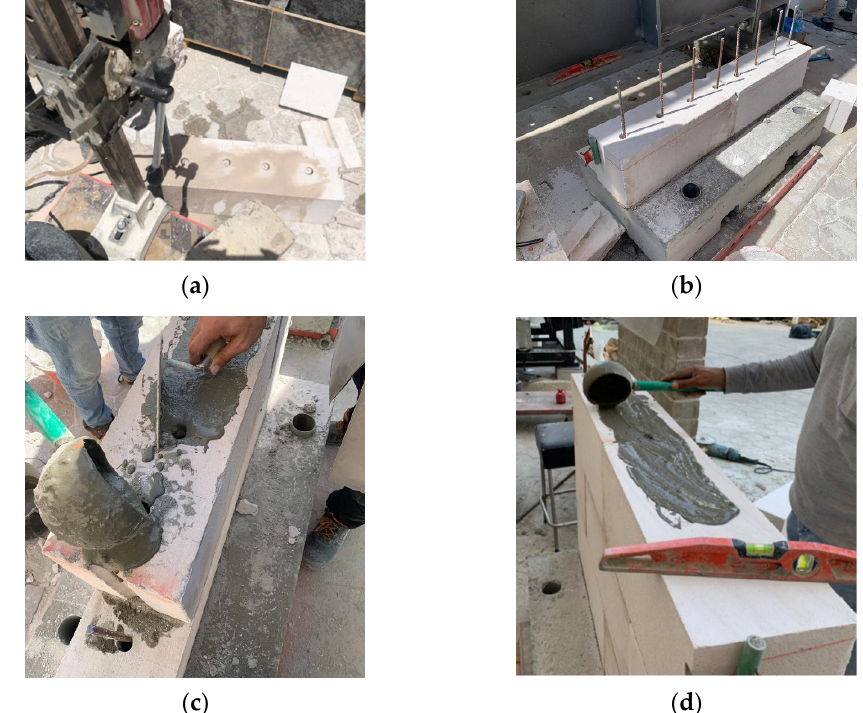
Figure 11. ( a ) Drilling holes in the first two block layers to run dowel bars through, ( b ) placement of the first block layer, ( c ) filling the holes with grout after the placement of the first two block layers, and ( d ) placement of the next layers with grouting layers in between.